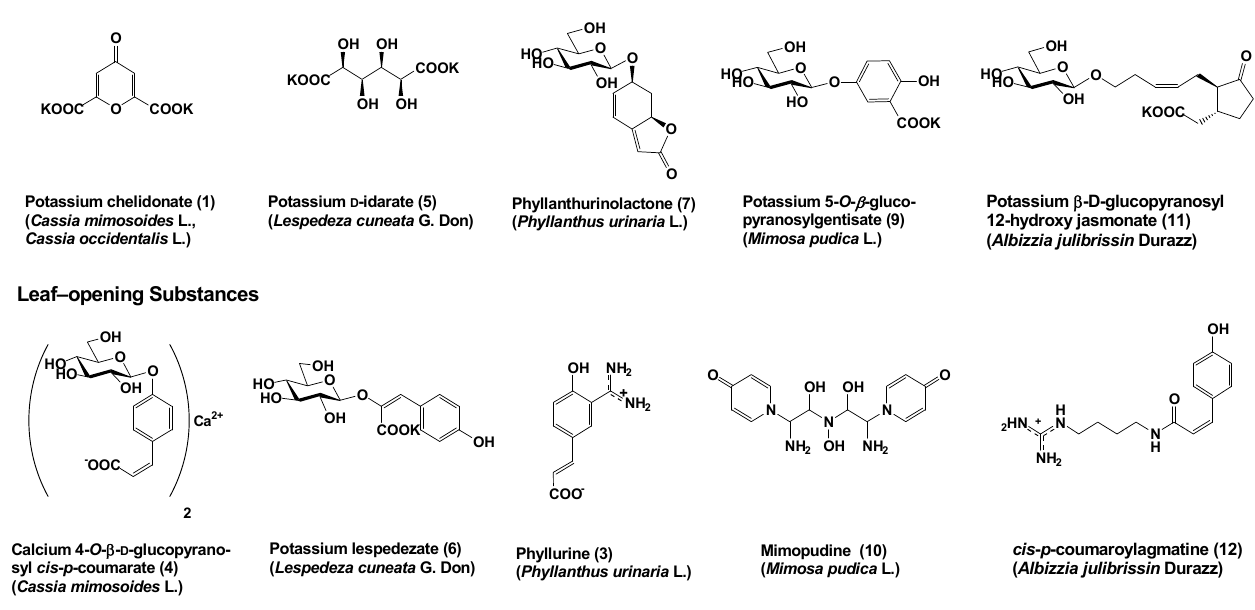
Figure 1. Leaf-movement factors from nyctinastic